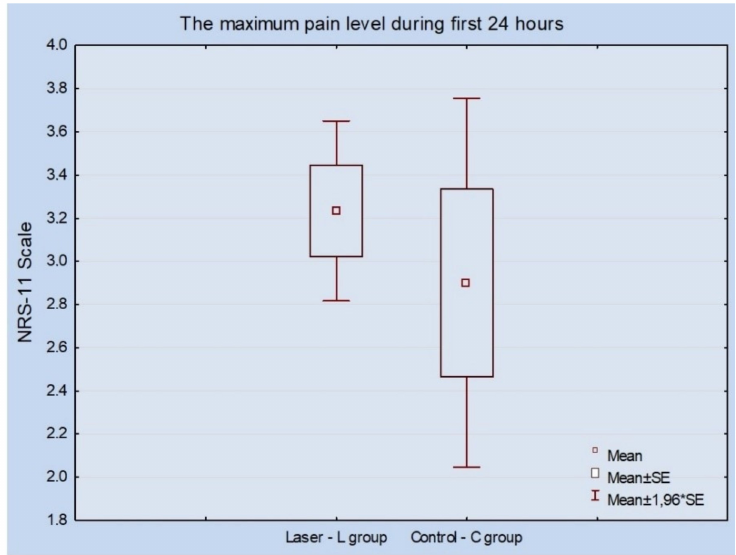
Figure 4. The highest pain score was achieved at 24 h post micro-implant placement.